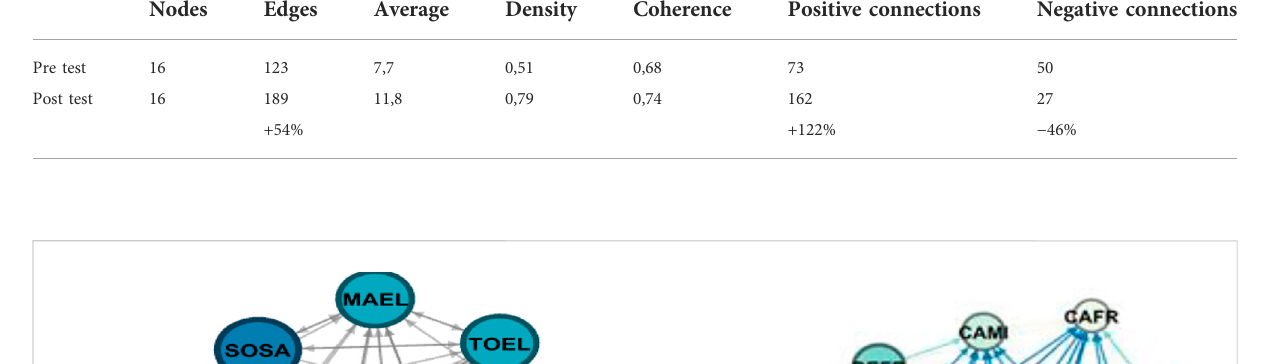
TABLE 1 Sociometric index calculated for the group involved in the trial (affective/relational). Nodes